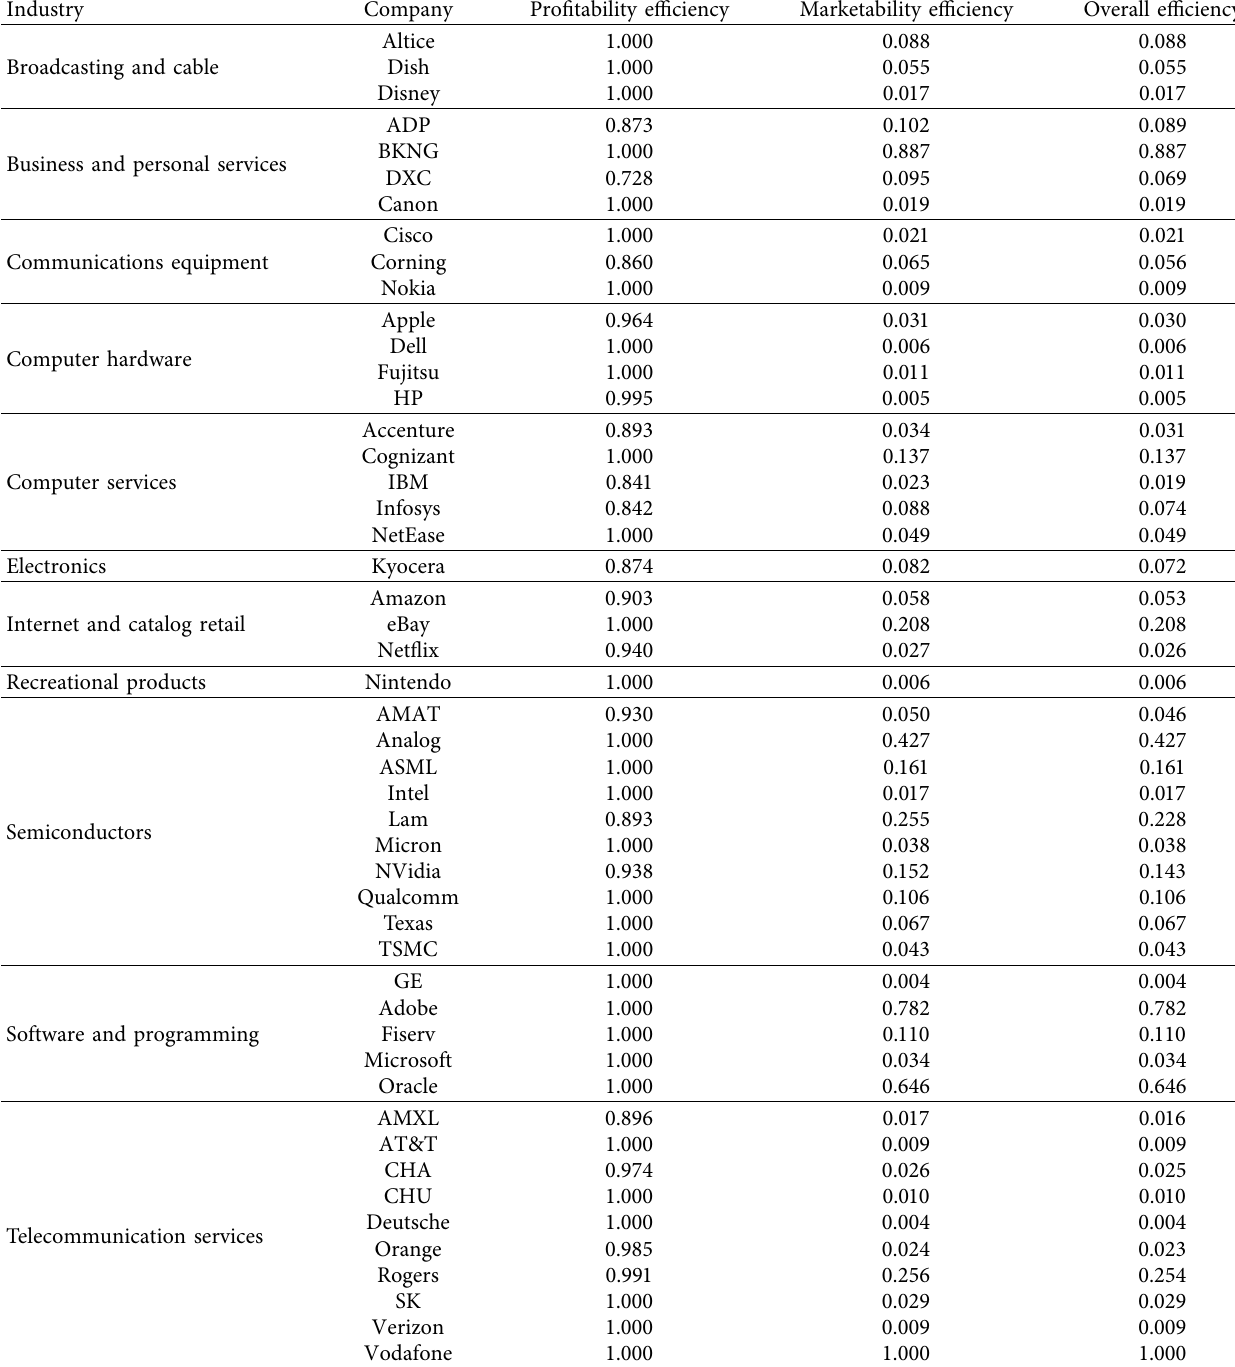
Table 4: Efficiency scores of the digital